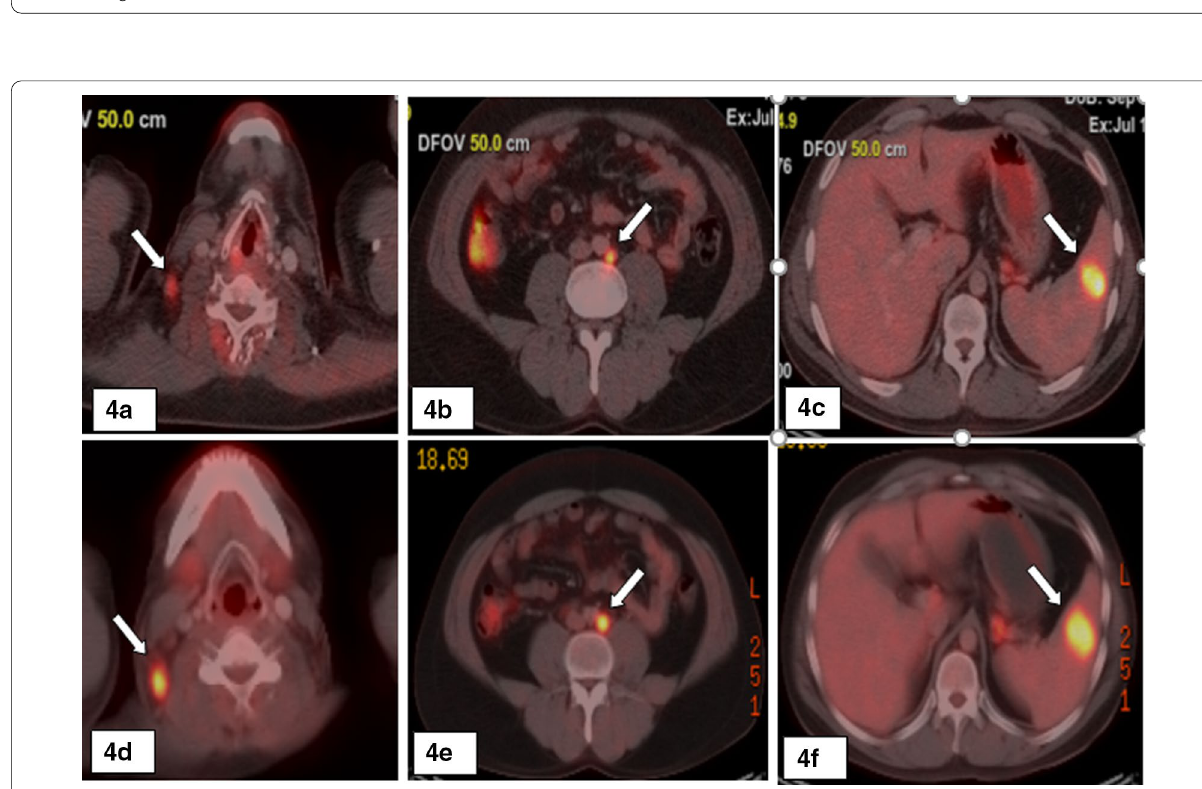
Fig. 4 35-year-old male patient, pathologically proved case of HL, initial PET/CT shows FDG-avid a right posterior triangle (exhibiting: SUVmax of 4.6, MTV of 2 cm 3 , and TLG of 18 gm/ml), b left paraaortic lymph nodes (exhibiting: SUVmax of 4.5, MTV of 5.5 cm 3 , and TLG of 25 gm/ml) and c extra-nodal splenic focal lesion (exhibiting: SUVmax of 6.9, MTV of 16 cm 3 , and TLG of 25 gm/ml), post-treatment PET/CT (after 6 weeks) shows PMD as following: d right posterior triangle lymph node (exhibiting: SUVmax of 8, MTV of 6 cm 3 , and TLG of 25 gm/m), e left paraaortic lymph node (exhibiting: SUVmax of 7.8, MTV of 14.9 cm 3 , and TLG of 33 gm/ml), f splenic focal lesion (exhibiting: SUVmax of 8.5, MTV of 29 cm 3 , and TLG of 160